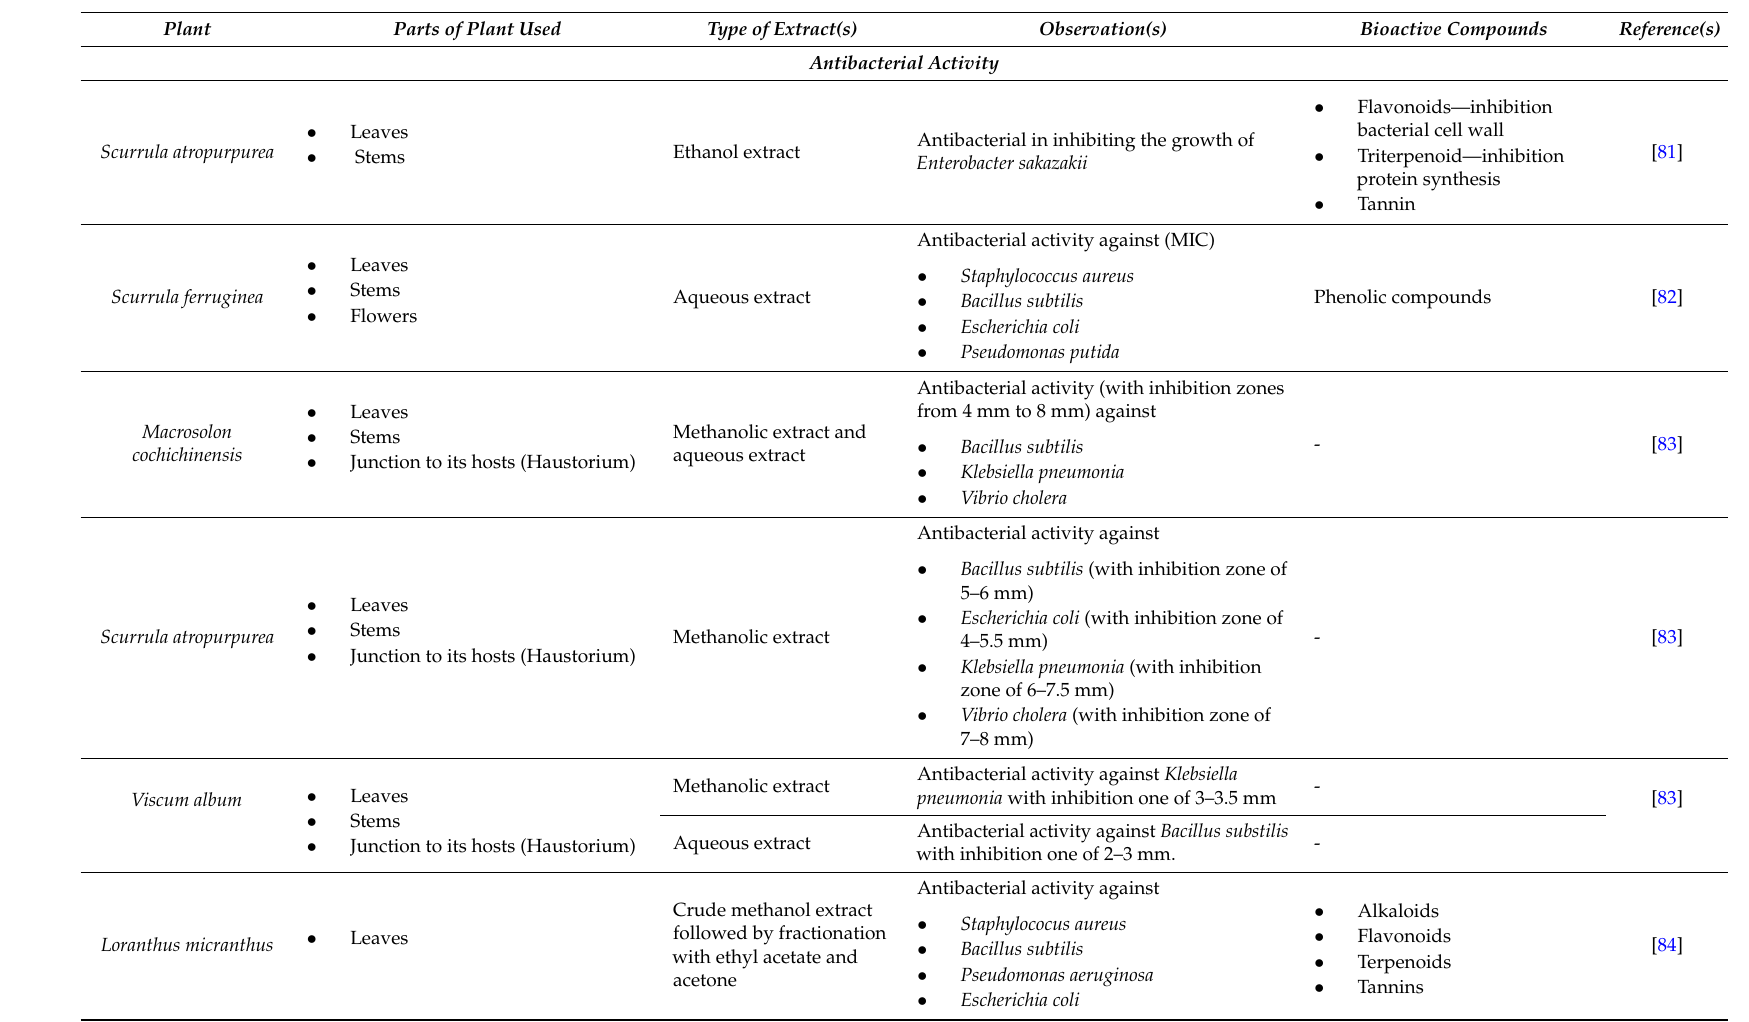
Table 4. Biological activities of compounds isolated from the parasitic